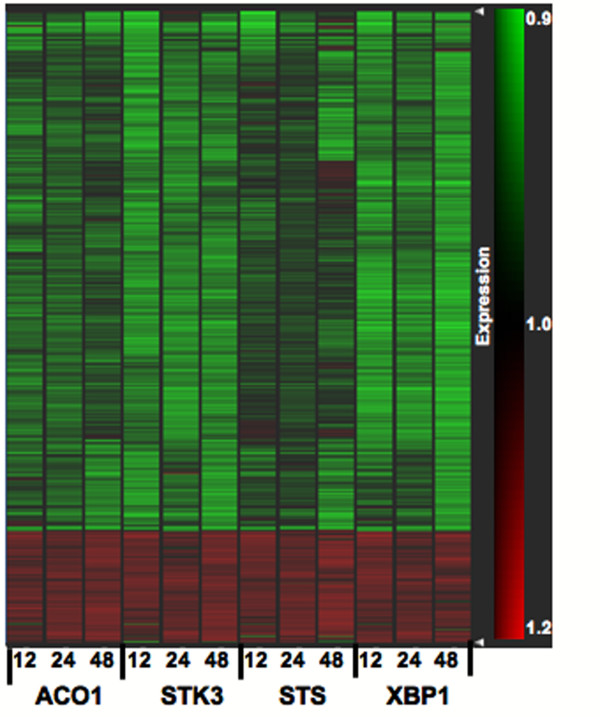
Gene tree prepared with the list of 997 differentially expressed transcripts. The tree was generated using the Spearman correlation algorithm within GeneSpring. Expression is shown in fold change compared to the appropriate mock transfection control. Red – genes increased in expression; Green – genes decreased in expression; Black – unchanged.